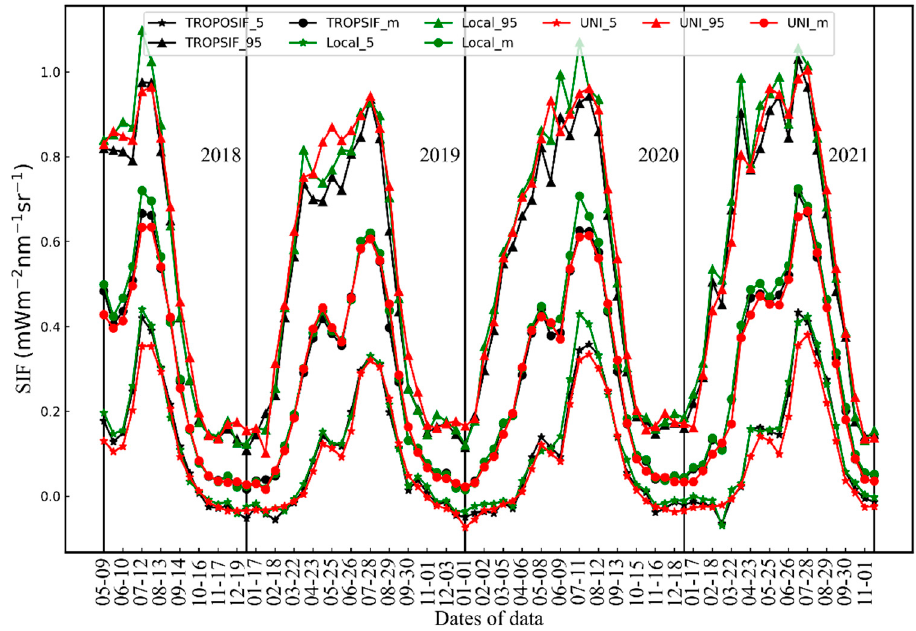
Figure 7. TROPOSIF_5, TROPOSIF_95, and TROPOSIF_m means in the 5th percentile, the 95th percentile, and the mean of TROPOSIF, respectively; TSIF_5, TSIF_95, and TSIF_m are the 5th percentile, the 95th percentile and the mean of TSIF, respectively; UNI_5, UNI_95, and UNI_m are the 5th percentile, the 95th percentile, and the mean of USIF, respectively.